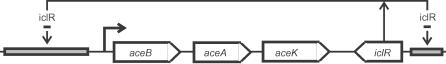
Schematic of Negative Regulation of the Acetate Operon aceBAK and the iclR Gene by iclR [22,33]Failure to negatively regulate aceBAK would result in constitutive expression of the operon.